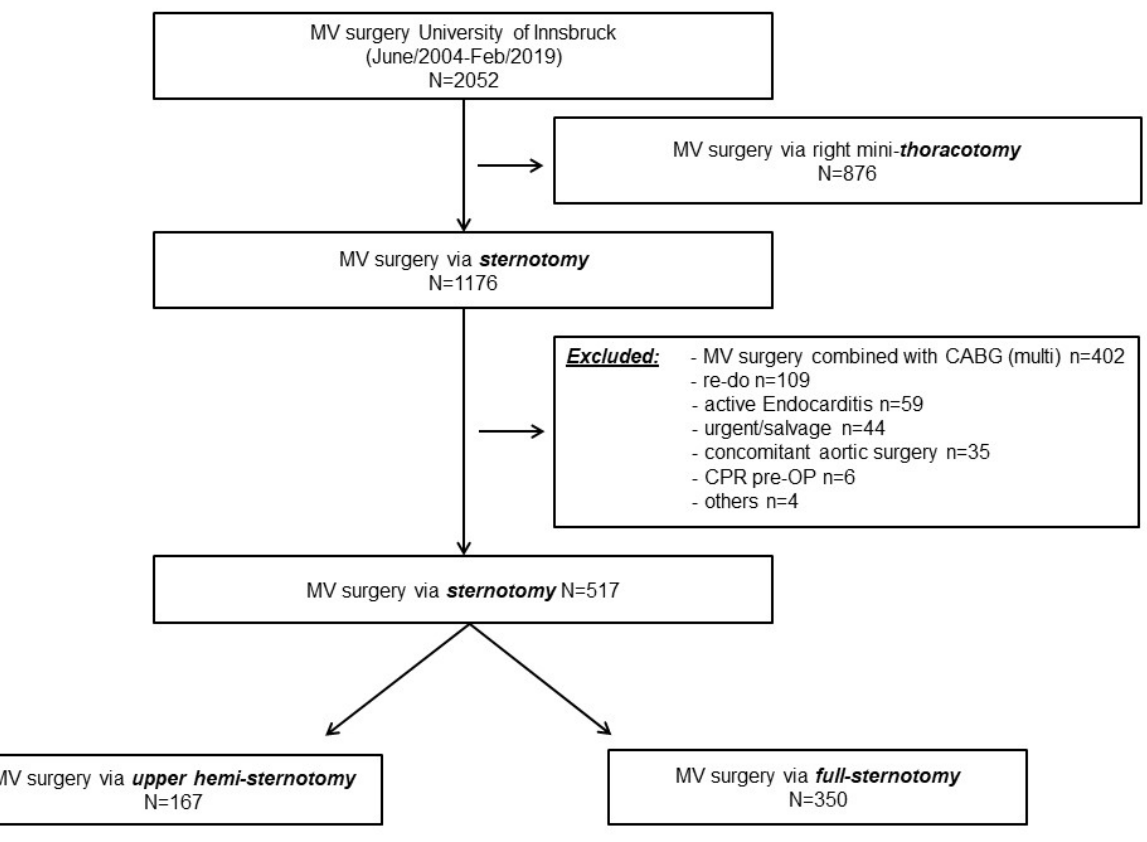
Figure 1. Mitral valve surgery flowchart.